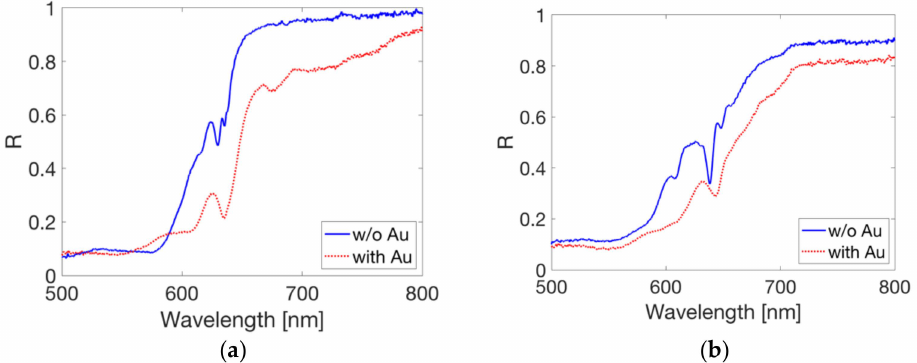
Figure 5. Measured reflectance spectra of both configurations without ( solid blue line ) and with a gold layer ( dashed red curve ), for ( a ) the bilayer and ( b ) the multilayer,